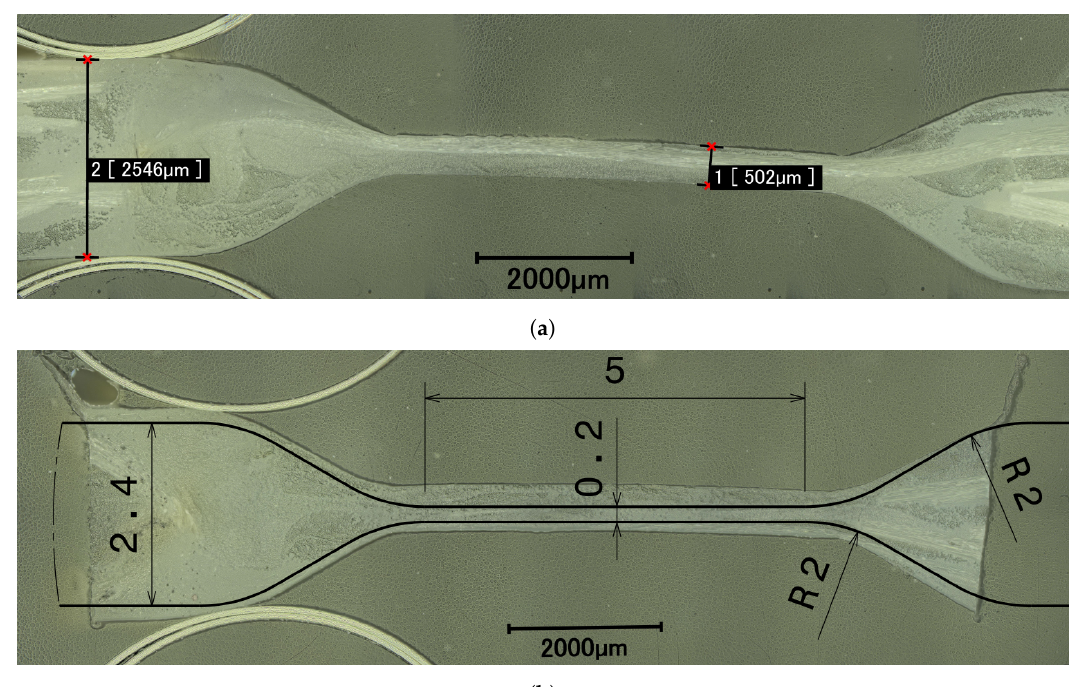
Figure 16. Microscope images of woven flexure hinges: Improved weaving parameters and 15.5 tex weft thread in hinge areas: ( a ) Twisted yarn/Twisted yarn. ( b ) TecTape/Twisted yarn.